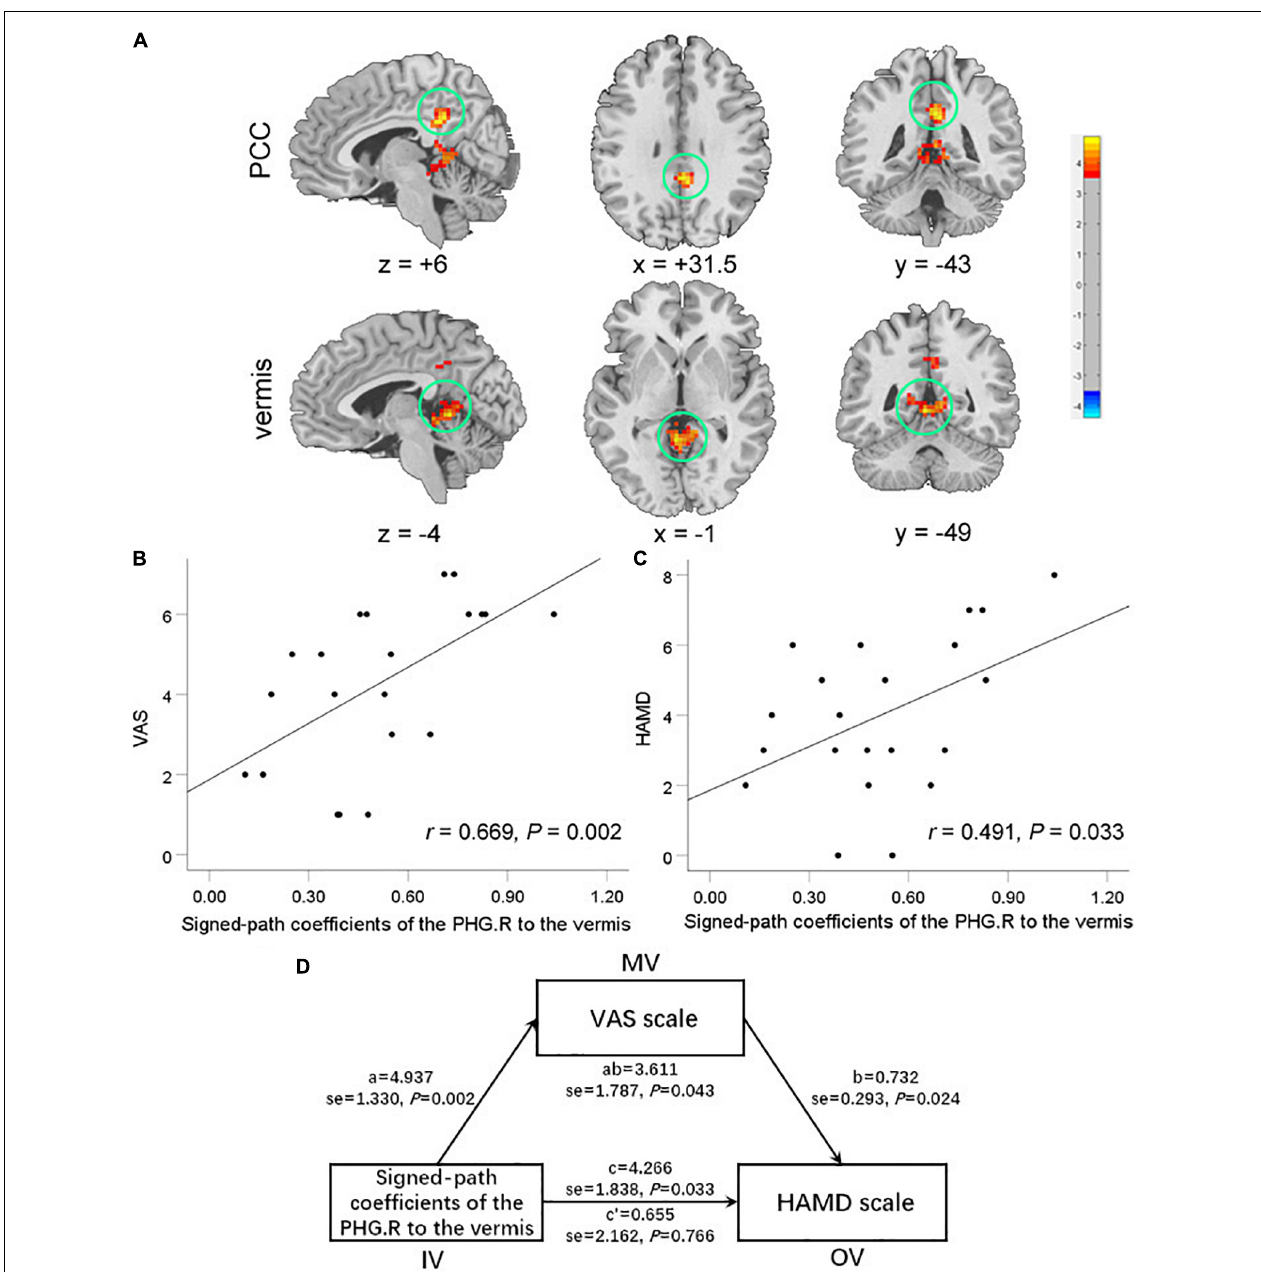
FIGURE 2 | Brain regions exhibiting enhanced functional connectivity (FC) with the right PHG in temporomandibular disorders (TMD) patients compared with healthy controls (A) . There were significant positive correlations between the FC of the right PHG with vermis and the visual analog scale (VAS) scores (B) and the HAMD scores (C) . The oral-facial pain completely mediated the relationship between the FC of the right PHG with vermis and the HAMD scores (D) . PCC, posterior cingulate cortex; PHG, parahippocampa gyrus; VAS, Visual Analog Scale; HAMD, Hamilton Depression Rating